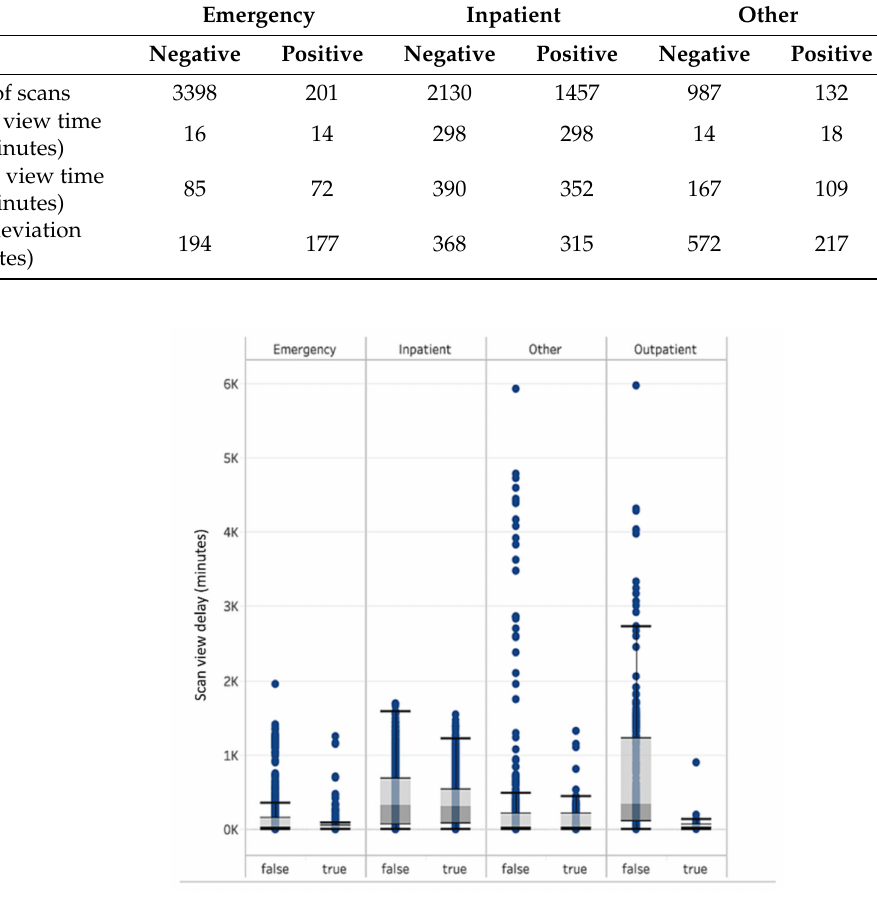
Figure 2. Boxplots of the scan view delay for flagged and non-flagged cases. Table 2. Performance parameters of the Aidoc software for acute intracranial hemorrhage